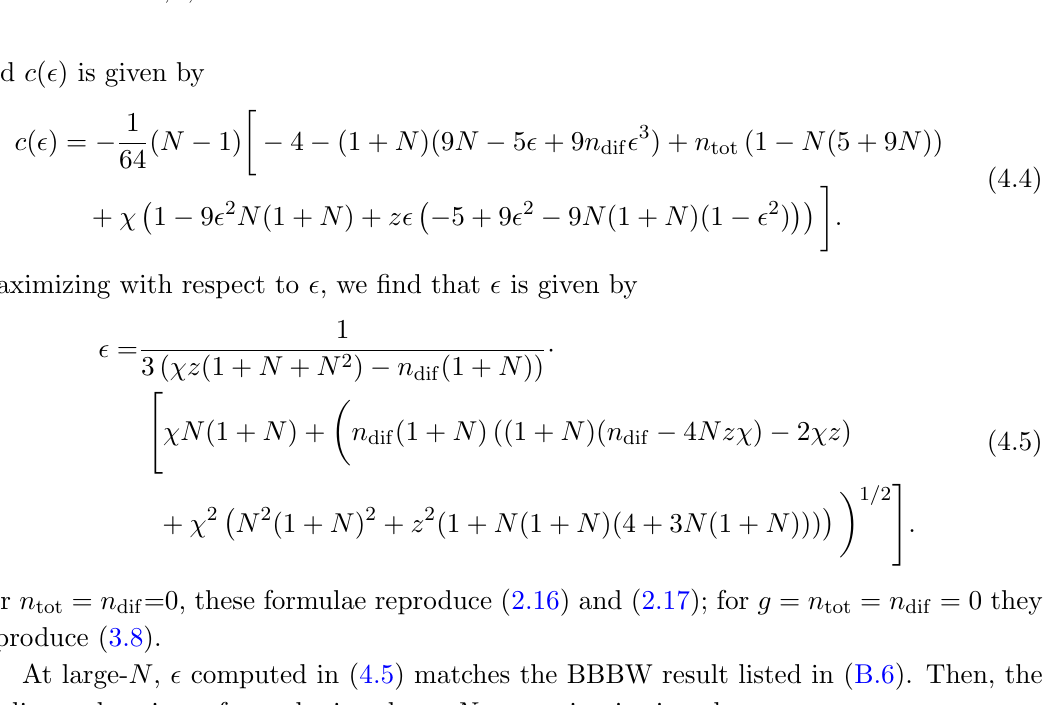
Figure 6. a as a function of the twist z for the g = 2 ; n tot = 1 theories represented in (cid:12)gure 5, plotted for N = 3 ; 4 ;